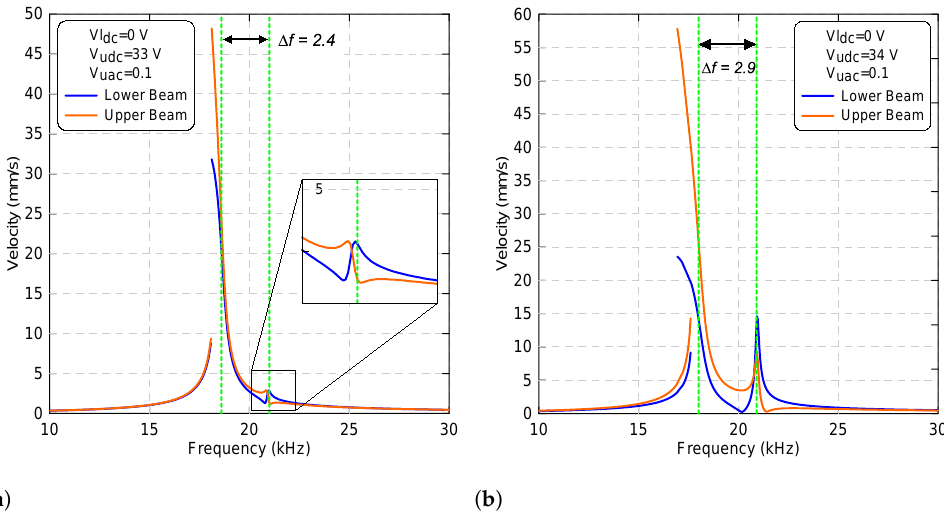
Figure 11. The frequency-response curves of the lower beam resonance frequency f l 1 and of the upper beam resonance frequency f u 1 with a lower voltage sets to V ldc = 0 V and a upper voltage sets to: ( a ) V udc = 33 V and ( b ) V udc = 34 V. The upper harmonic voltage V uac is set to 0.1 V. The lower beam results are marked with blue lines and the upper beam results are marked with orange